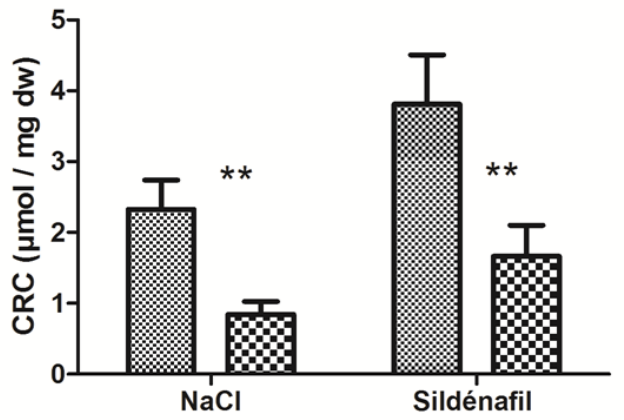
Figure 3. Calcium retention capacity (CRC) in ischemic and non-ischemic gastrocnemius in mice treated (n = 7) or not (n = 9) with sildenafil. For both NaCl and Sildenafil groups: left column, non-ischemic contralateral limb. Right column: Ischemic limb. Results are expressed as means ± SEM. **: p < 0.01.